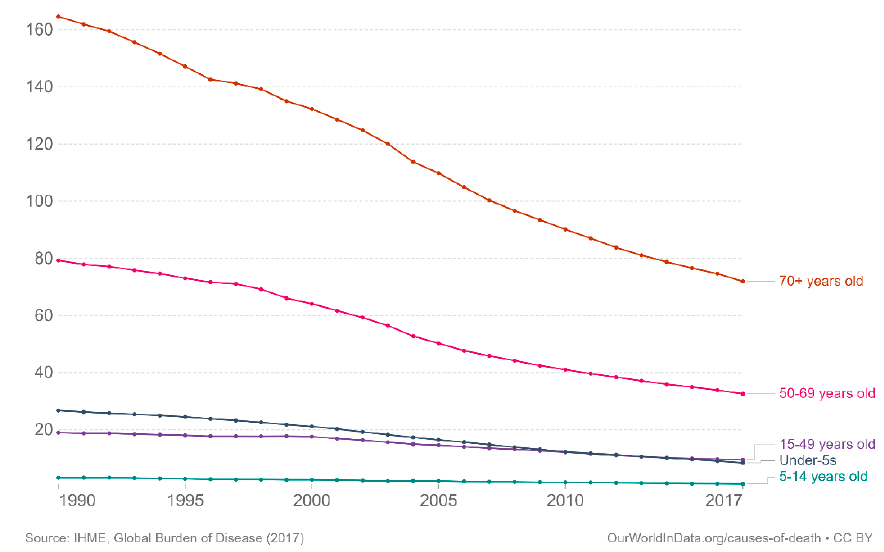
Figure 1. Death rate from tuberculosis by age in the World, 1990 to 2017 [8].